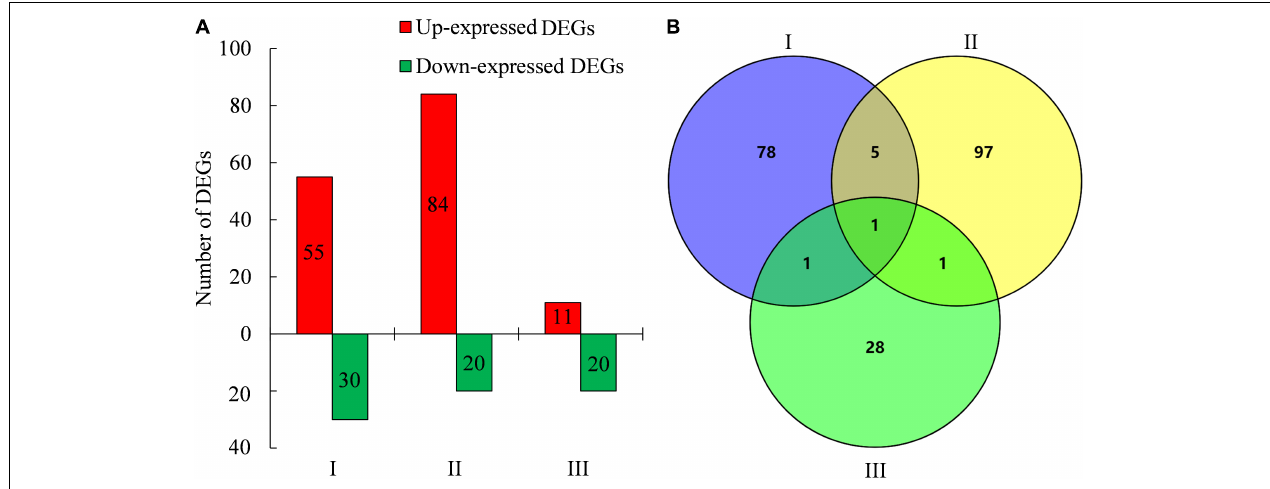
FIGURE 4 | Analysis of DEGs and Venn between WT and lazy1 at stage I (before bending), II (bending), and III (after bending) by RNA-seq. (A) The number of up-expressed and down- expressed DEGs between WT and lazy1 . (B) The number of common DEGs between WT and lazy1 by Venn